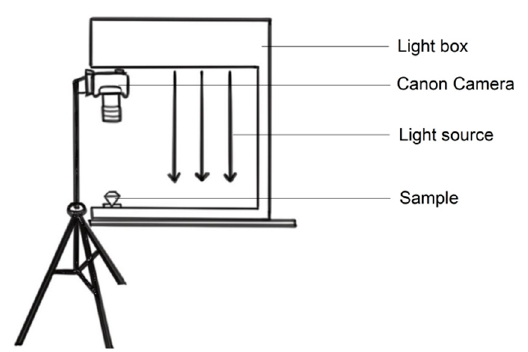
Figure 3. Schematic diagram of the photography measurements